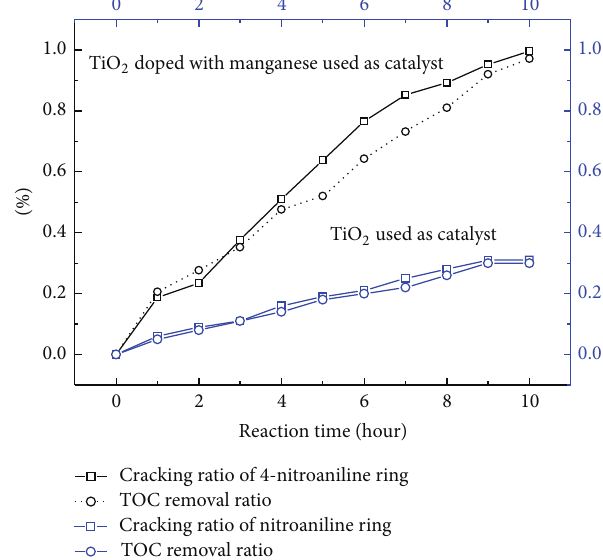
Figure 6: Comparison the performance of degradation of 4- nitroaniline on TiO 2 and TiO 2 doped with manganese (c (4- nitroaniline) = 100 mg/L; voltage = 12 V; ultraviolet ray dosage = 1200 𝜇 W/cm 2 ).